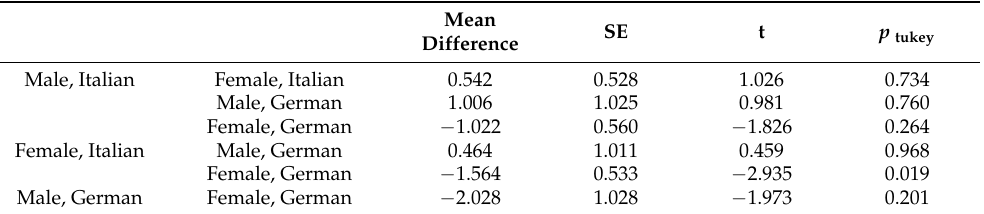
Table 7. Post Hoc Comparisons of gender respondents in the zoos. The p -value was adjusted for comparing a family of four using Tukey’s correction.